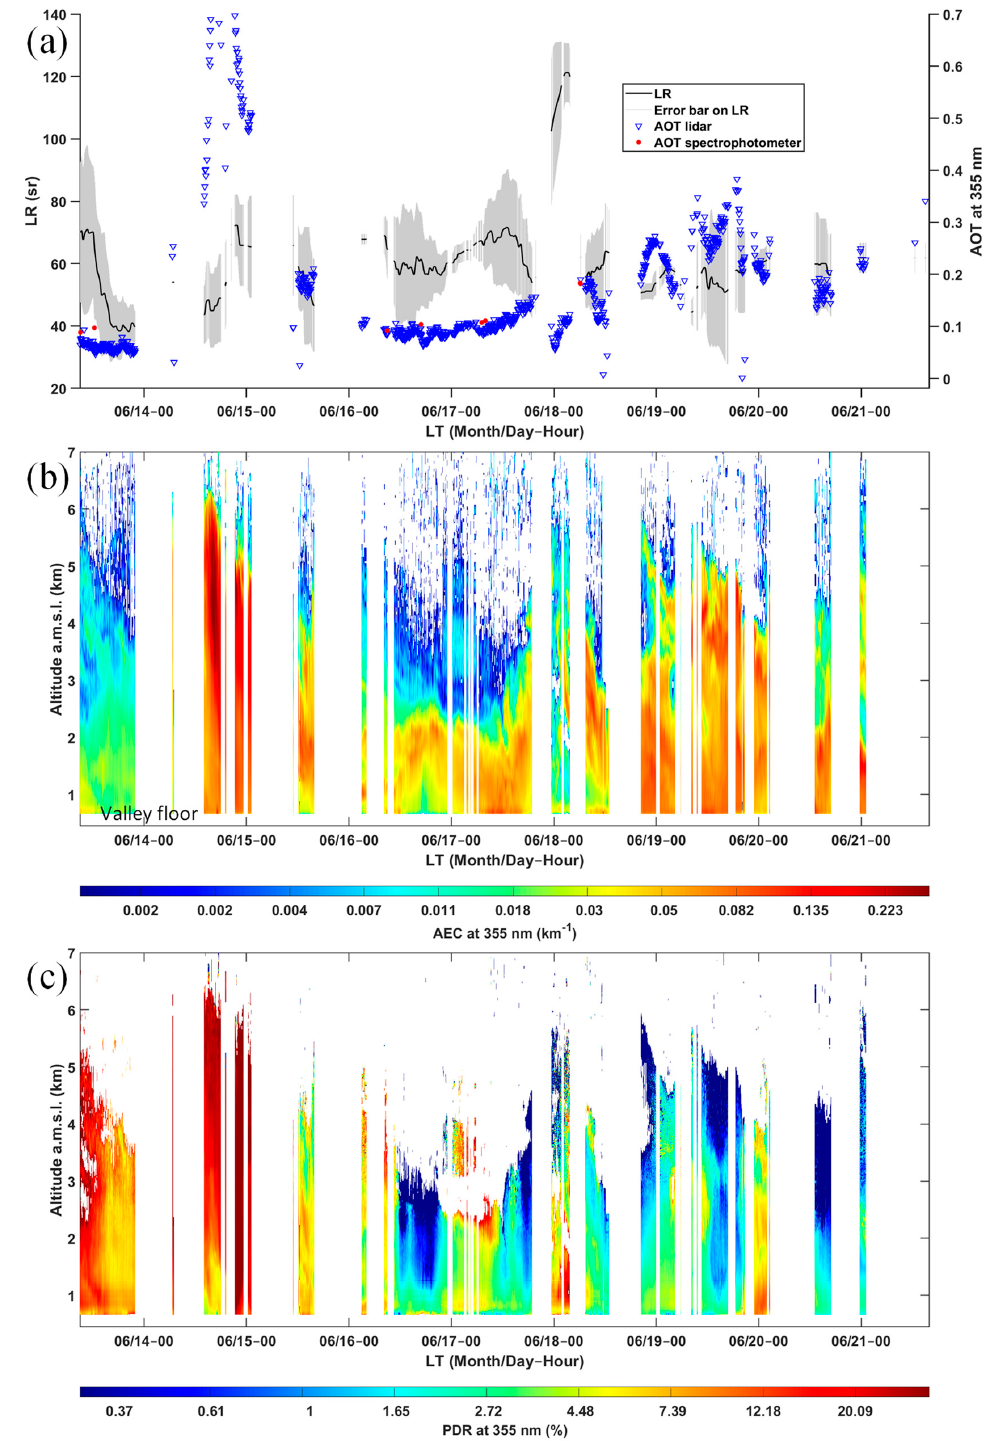
Figure 1. Temporal evolution between 13 and 21 June 2019 of ( a ) lidar ratio (LR) (mean value as a black line and error bar in orange), as well as the aerosol optical thickness (AOT) at 355 nm derived from lidar measurements (blue triangles) and the handheld sun spectrophotometer (red dots); ( b ) the vertical profile of the aerosol extinction coefficient (AEC) at 355 nm; and ( c ) the vertical profile of the particle linear depolarization ratio (PDR) at 355 nm. White stripes along time correspond to cloudy periods when measurements could not be